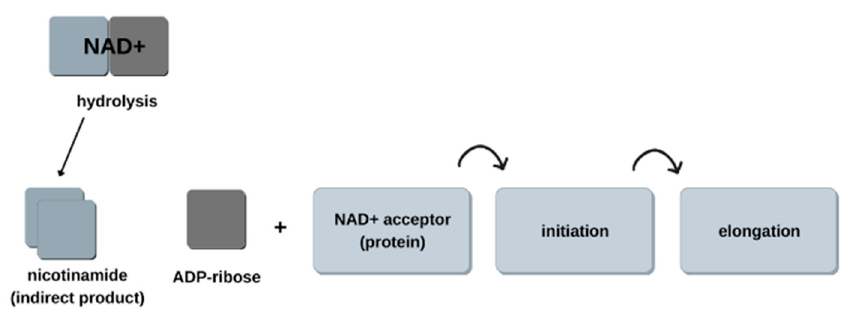
Figure 2. Diagram of the ADP-ribosylation process.